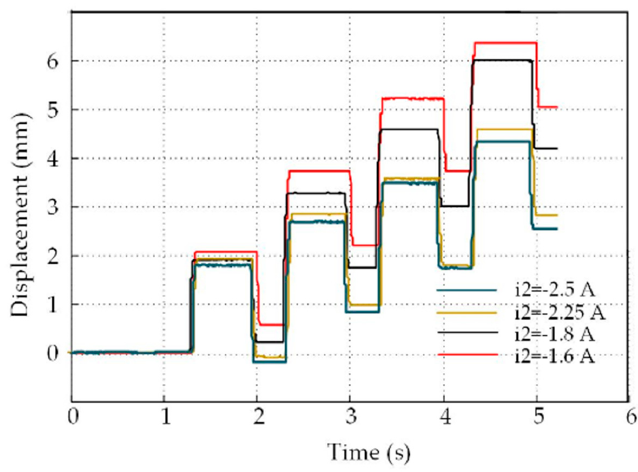
Figure 13. CR displacement vs. negative current amplitude.